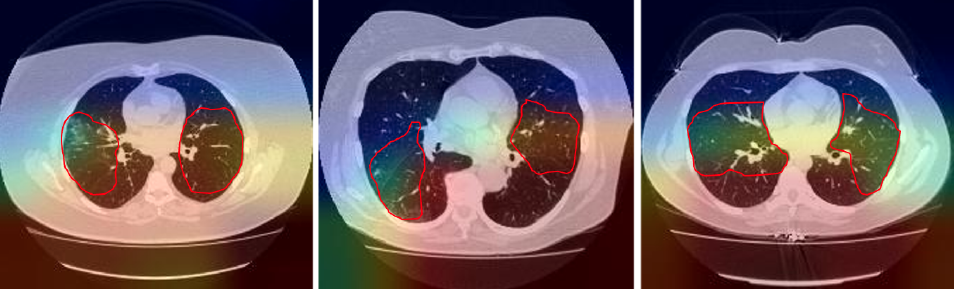
Figure 4. Class Activation Map